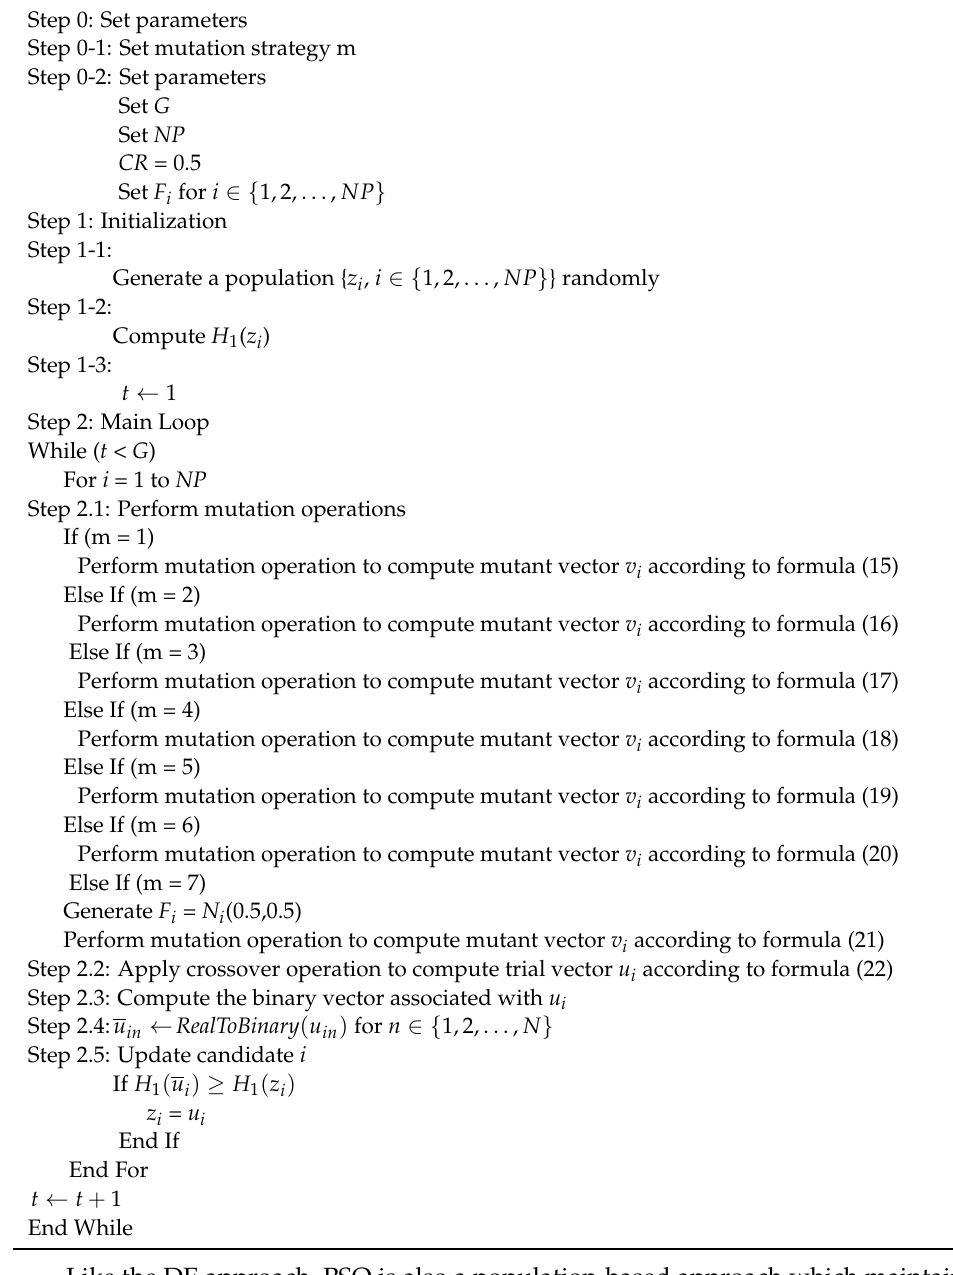
Algorithm 1. Discrete Differential Evolution (DE) Algorithm with Mutation Strategy